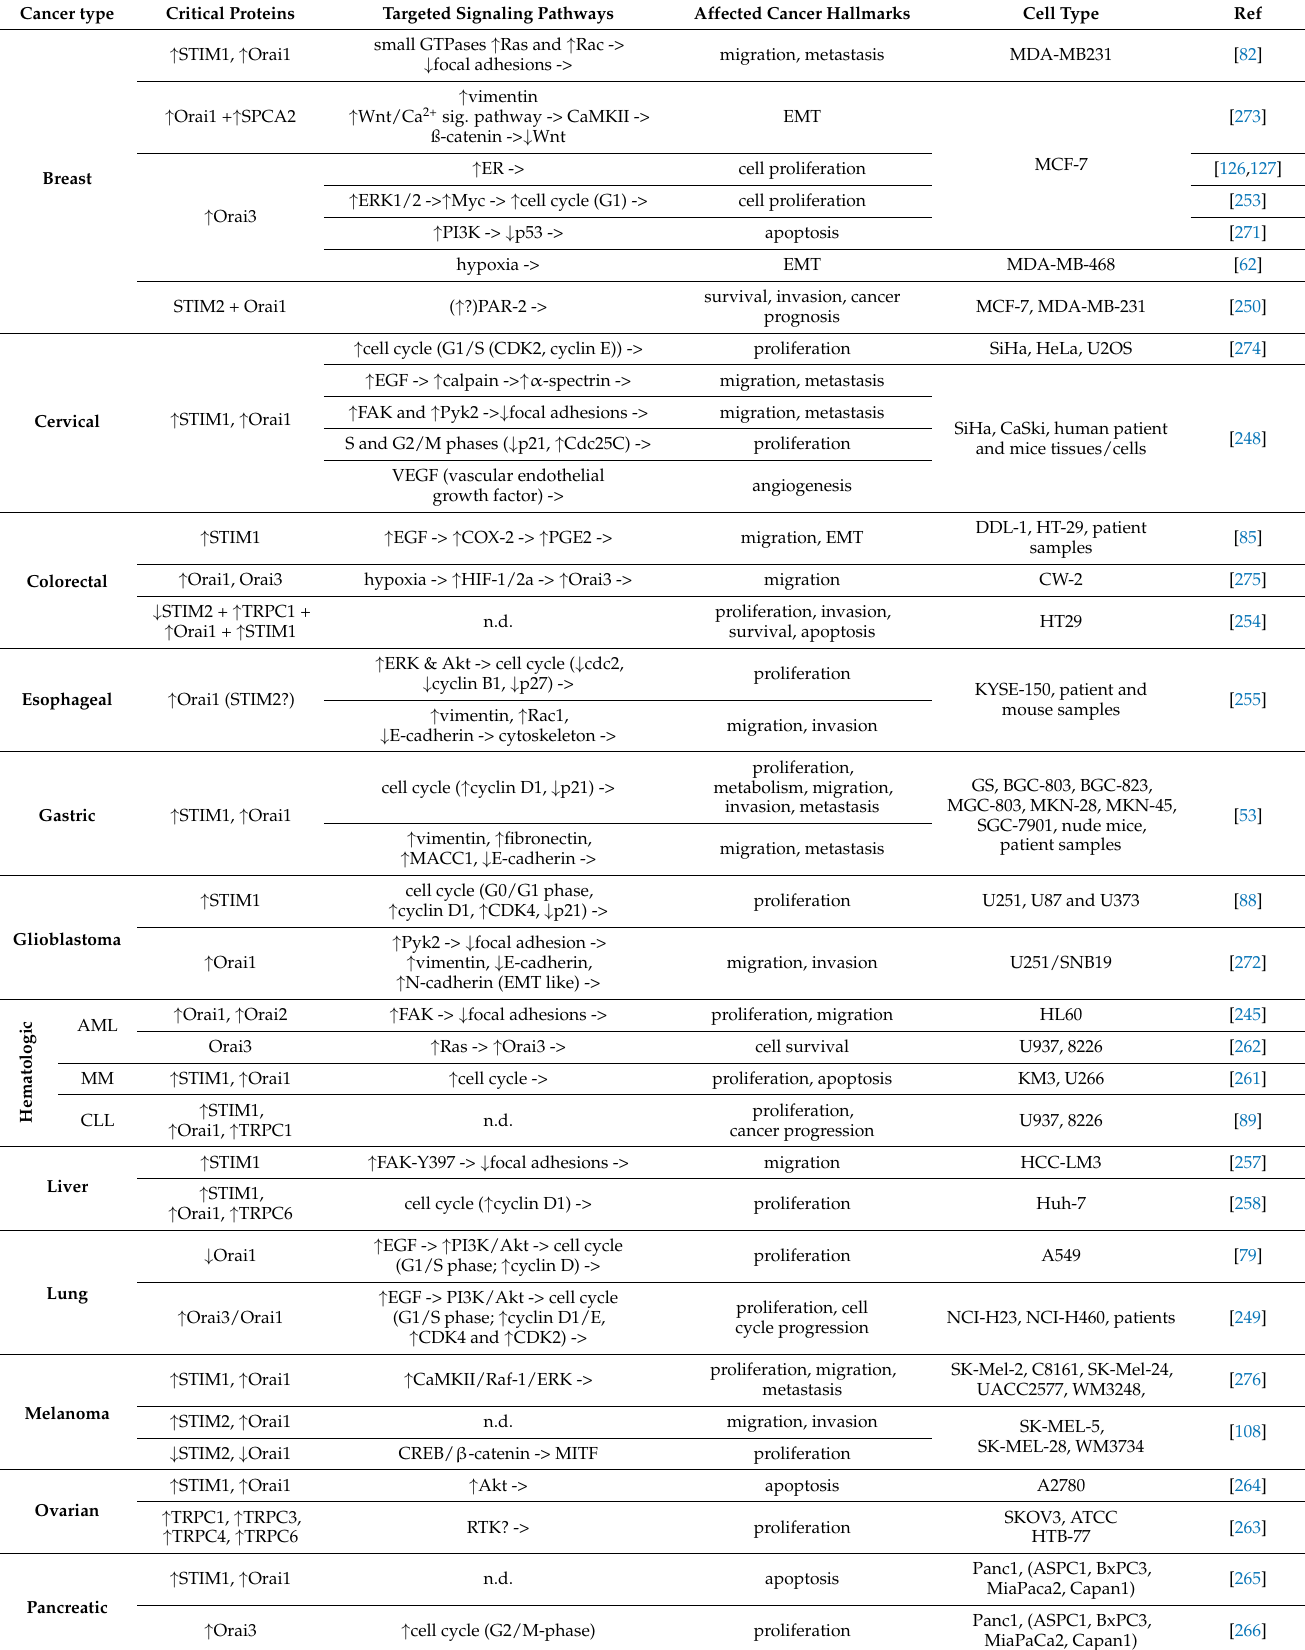
Table 1. Correlation of cancer types with critical CRAC channel